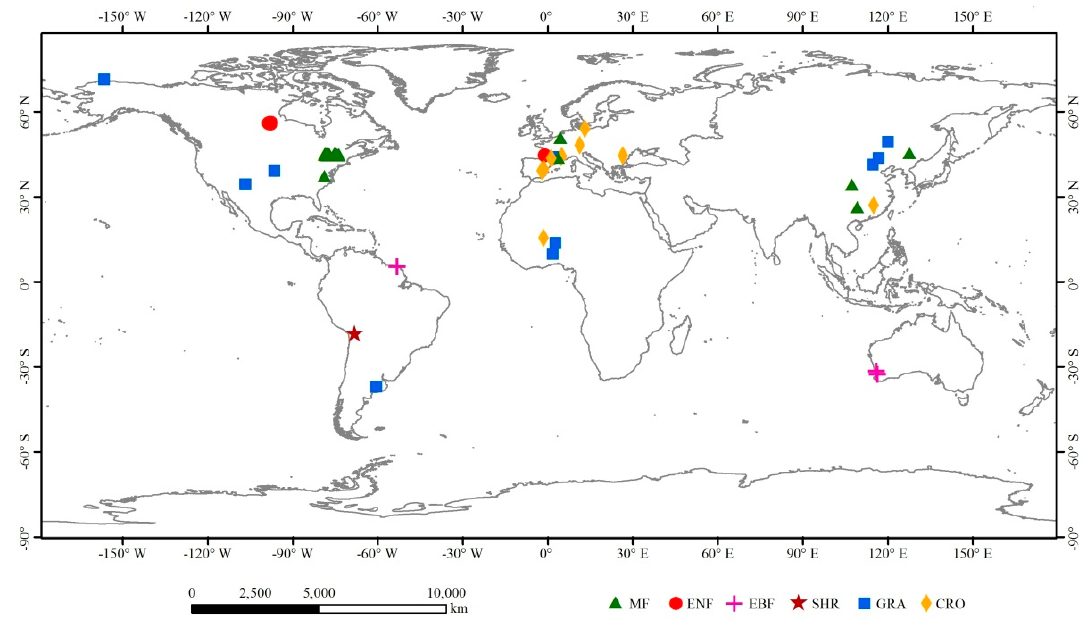
Figure 3. Distribution of field measurement LAI sites that are capable of direct LAI validation during 2001–2011.